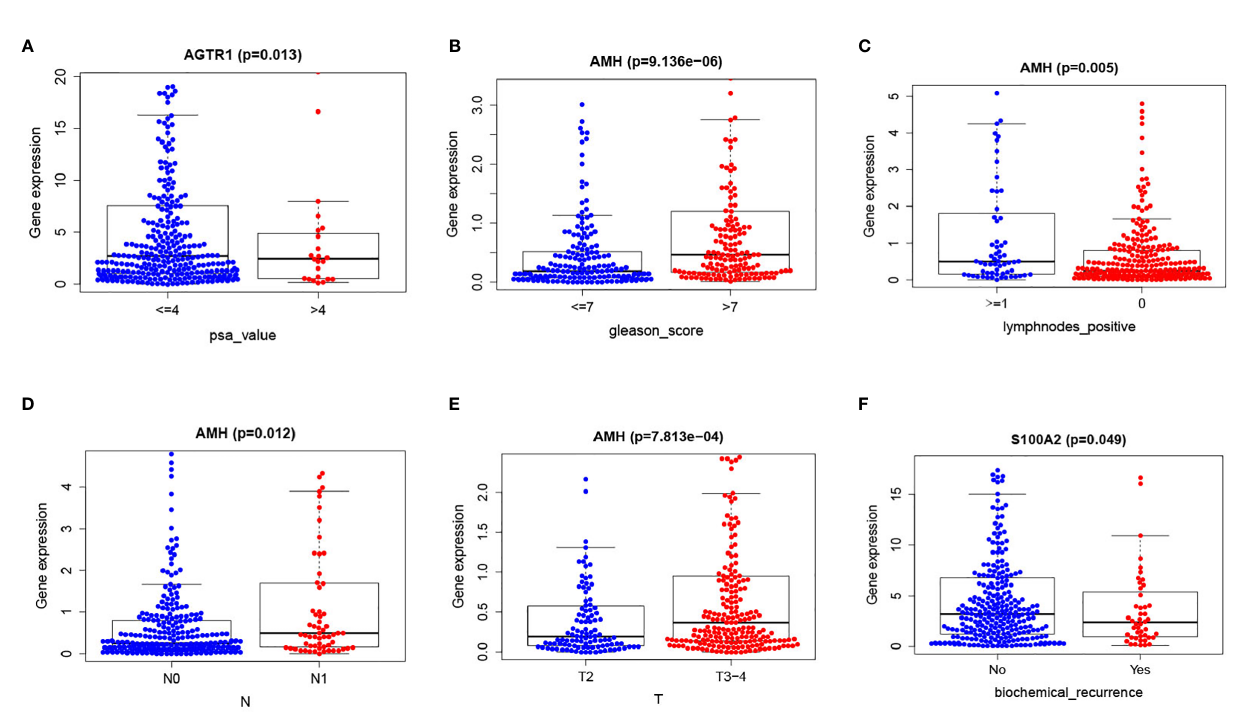
FIGURE 7 | Immune-related risk signature with clinicopathologic features correlations: (A) ATGR1 and PSA value; (B) AMH and Gleason score; (C) AMH and lymph nodes positive; (D) AMH and N; (E) AMH and T; (F) S100A2 and biochemical recurrence.